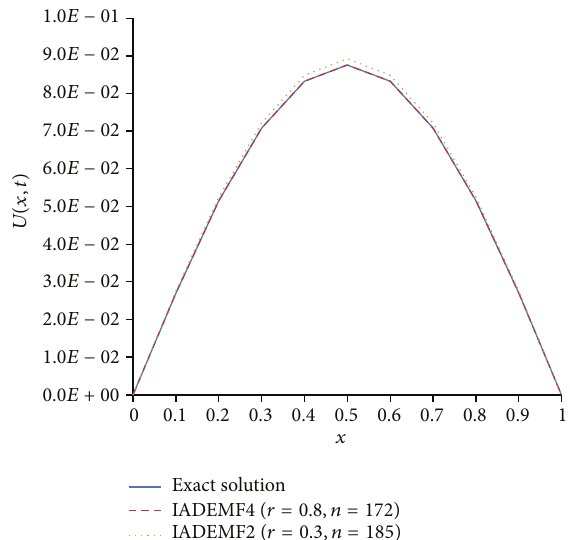
Figure 6: Numerical and exact solutions for Experiment 1. 𝜆 = 0.5 , Δ𝑥 = 0.1 , Δ𝑡 = 0.005 , 𝑡 = 0.25 , and 𝜀 = 10 −4 .